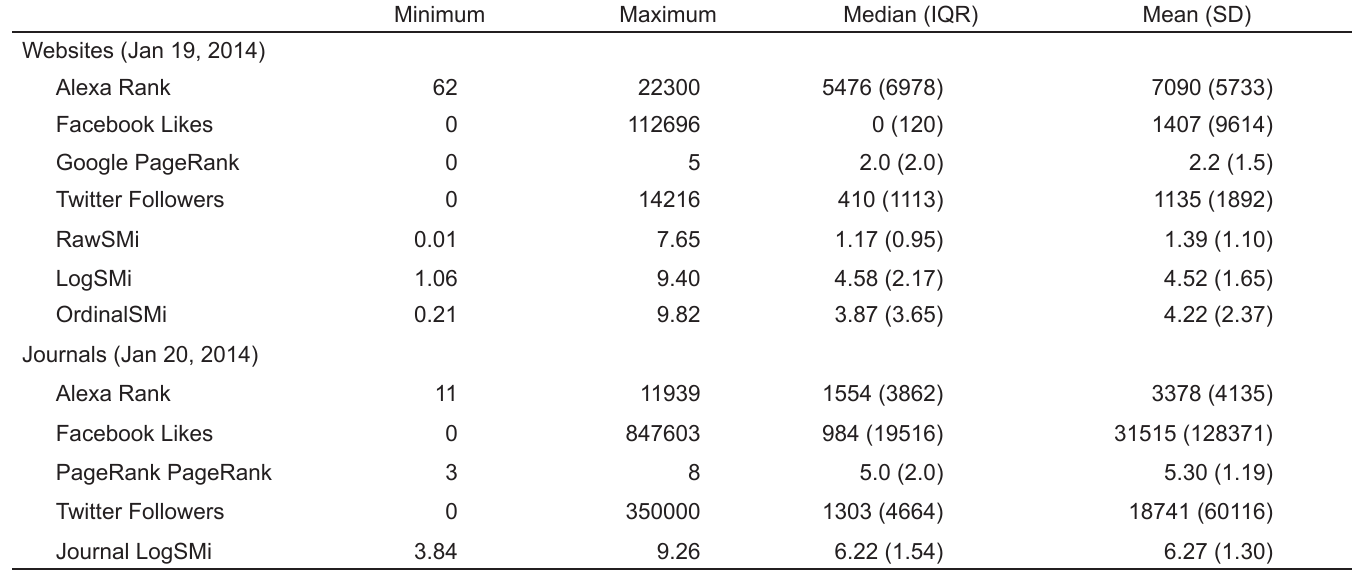
Table 2. Summary statistics for the Social Media index and their individual components (163 websites and 29 journals).